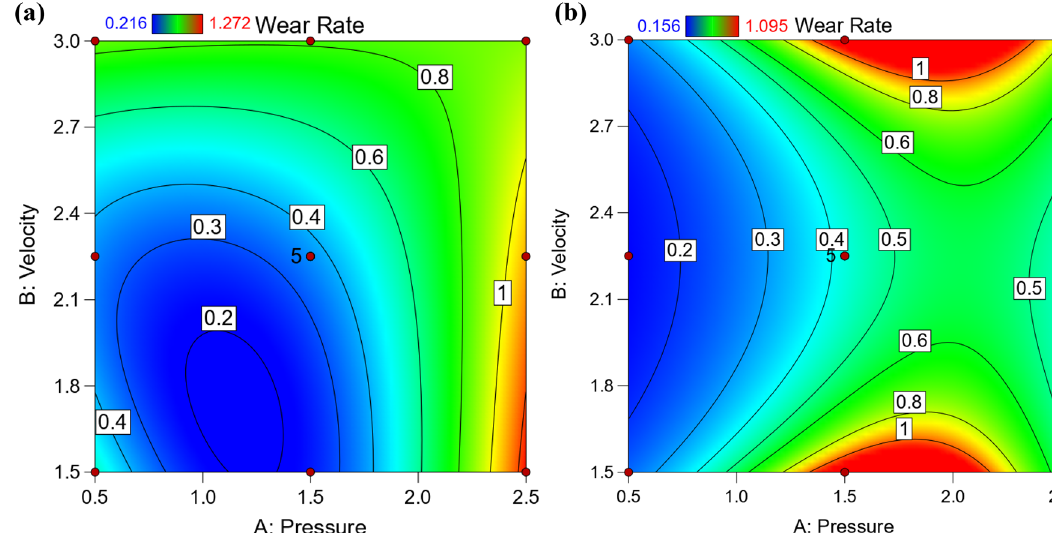
Figure 4. Contour map of wear rate in terms of pressure and velocity: ( a ) hot-rolled and ( b ) QAM f .